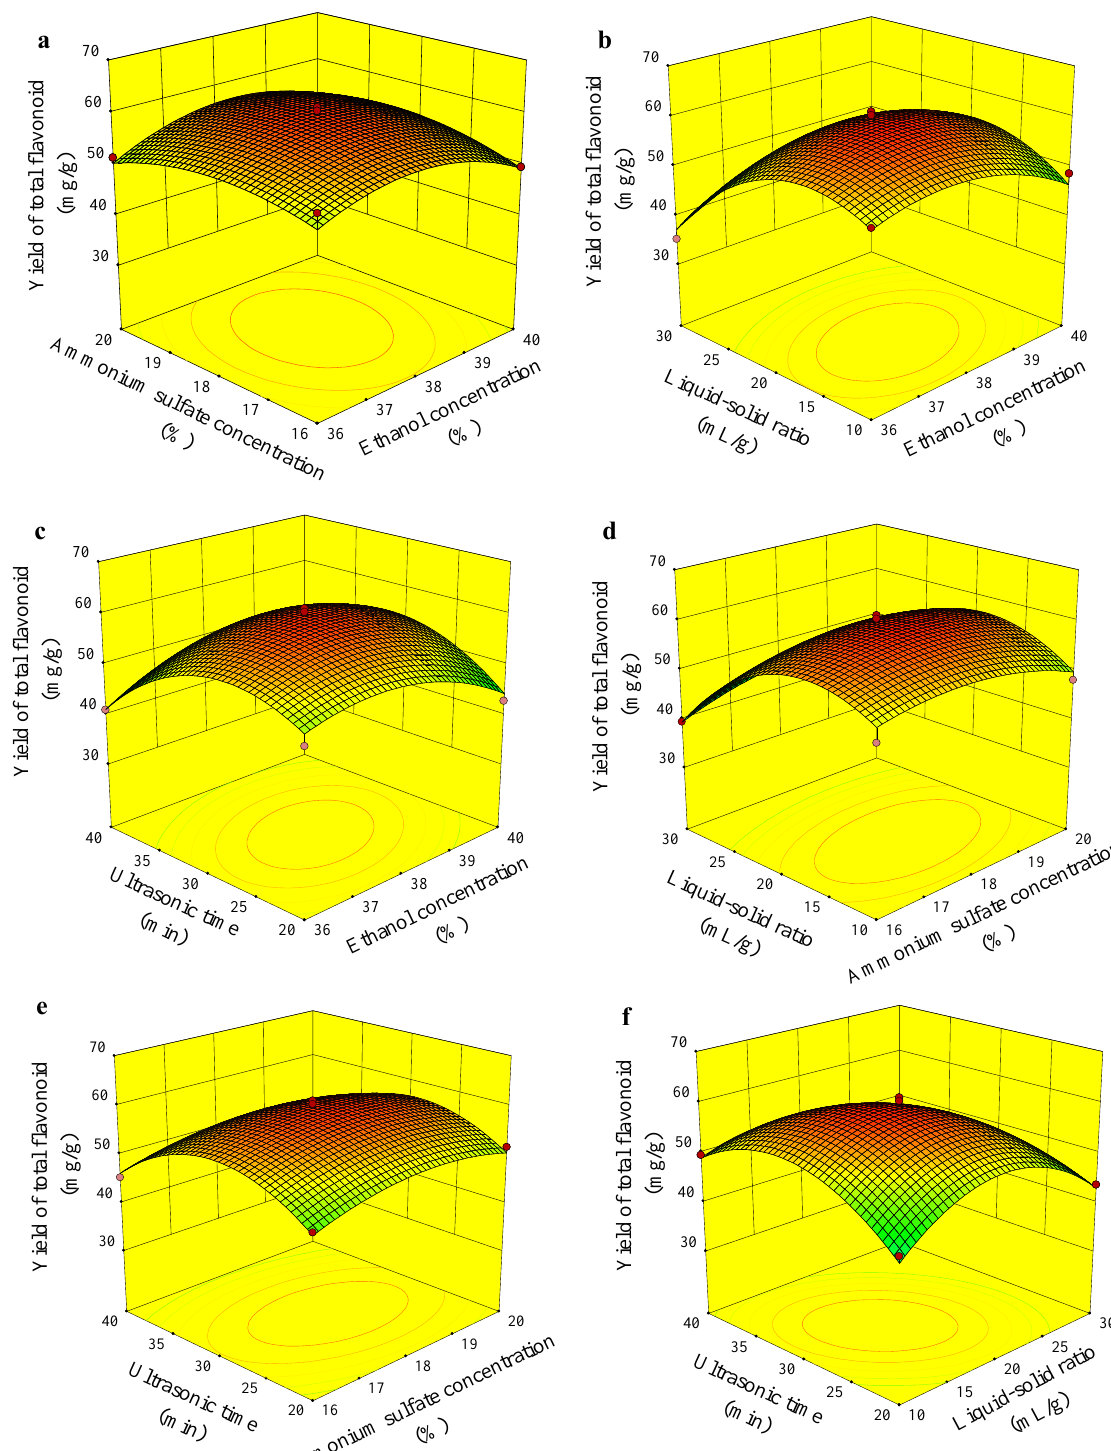
Design-Expert?Software Factor Coding: Actual R1 Design points above predicted value Design points below predicted value 61.078 30.868